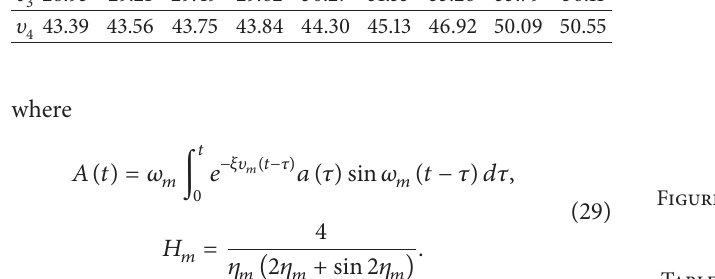
Table 3: The overshoot 𝑀 𝑃 % with different damping coefficient 𝜉